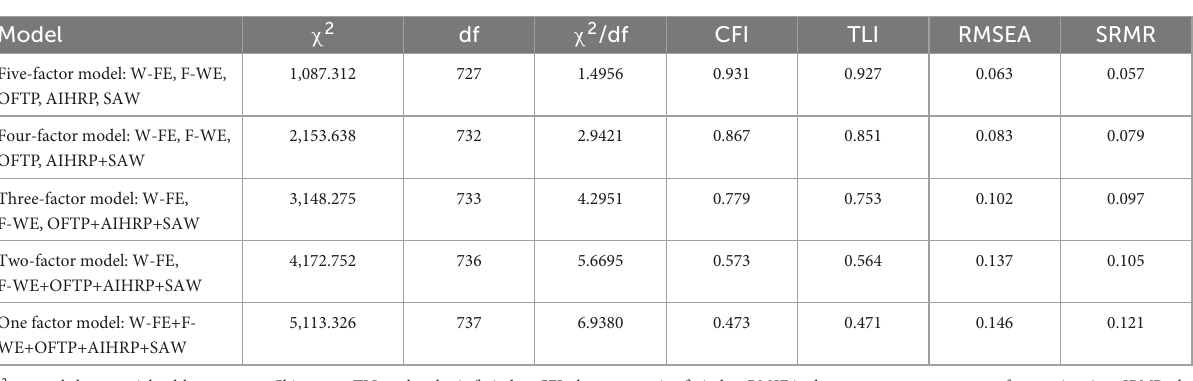
TABLE 1 Results of the confirmatory factor analysis ( N = 338).